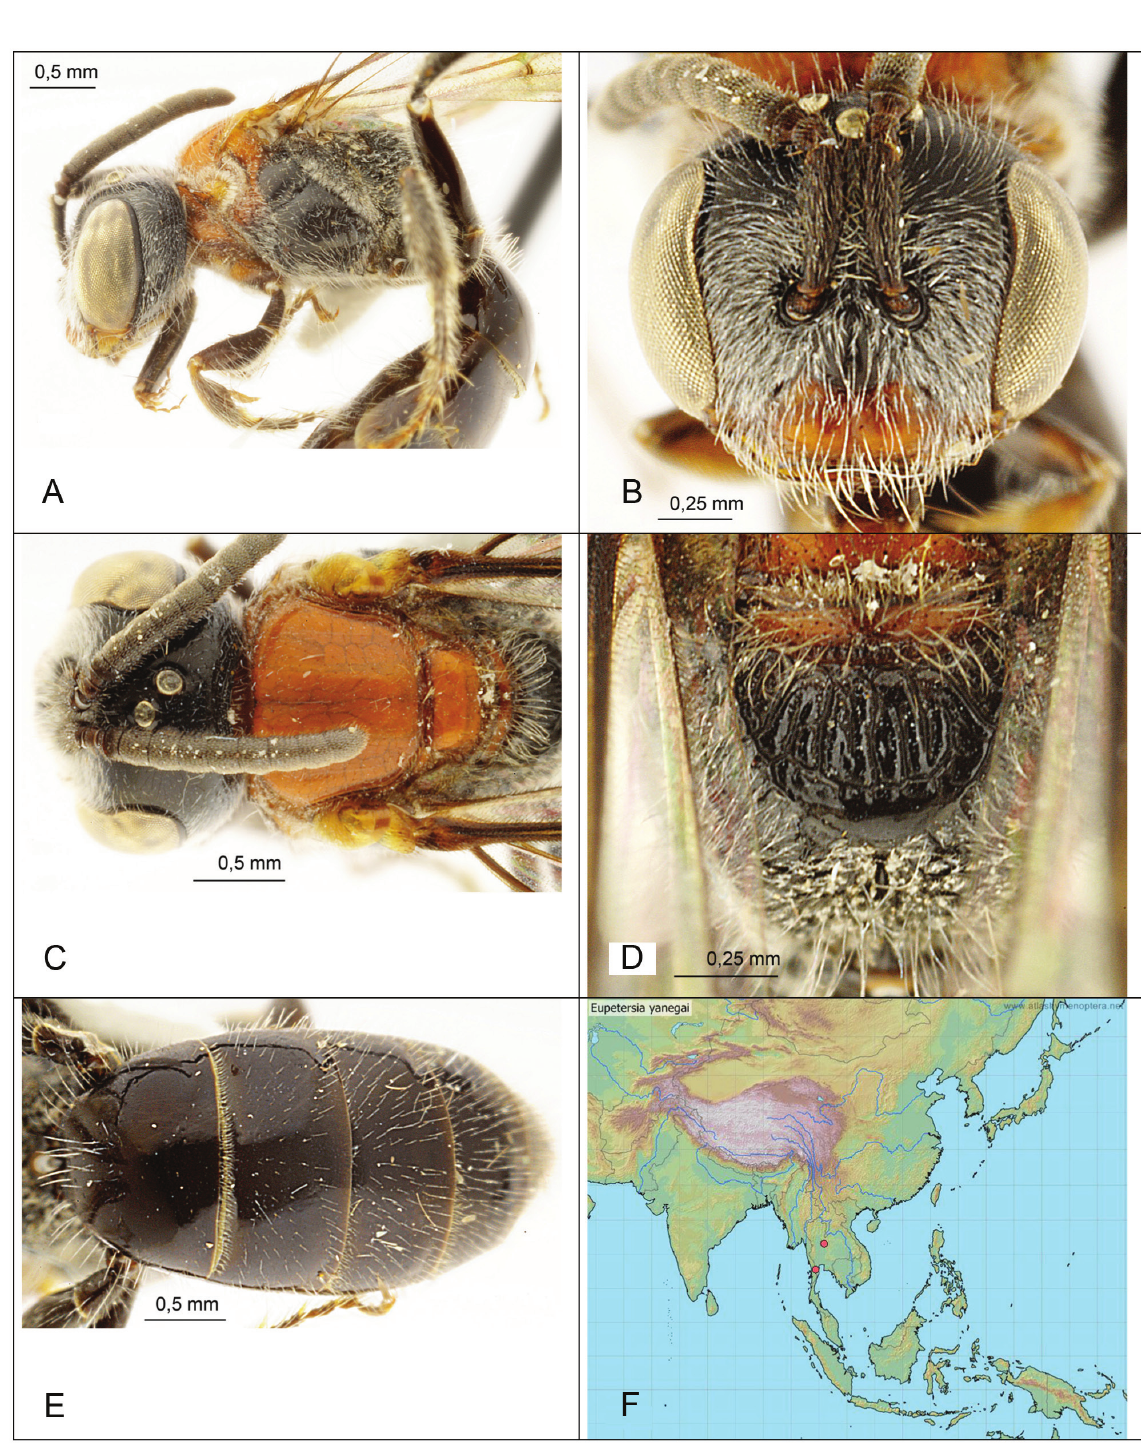
Fig. 5. Eupetersia yanegai sp. nov, ♀ paratype. A . Lateral view of head and mesosoma. B . head, facial view. C . head and mesosoma, dorsal view. D . Propodeum. E . Metasoma. F . Geographic